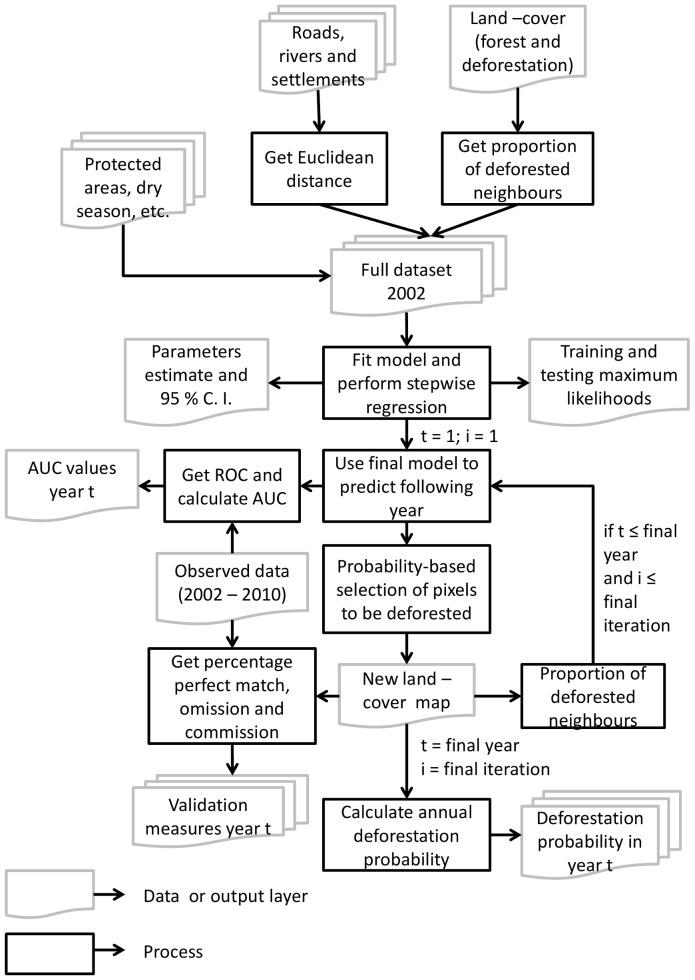
Modelling procedure flowchart.The flowchart illustrates the construction and running of the deforestation model. i is the model iteration, t is the year, ROC refers to the Receiver Operating Characteristic and AUC is the area under the ROC curve.